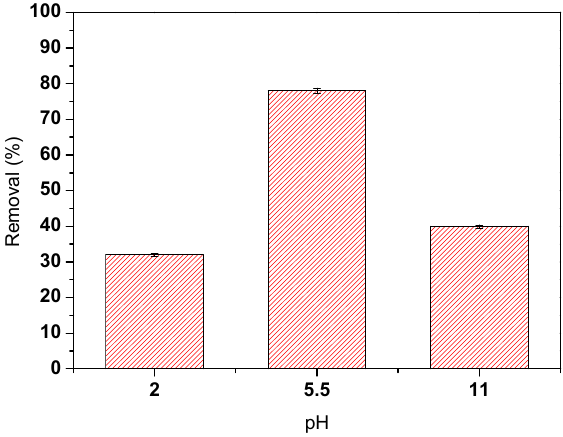
Figure 4. The influence of the initial pH on oily water photocatalytic degradation.